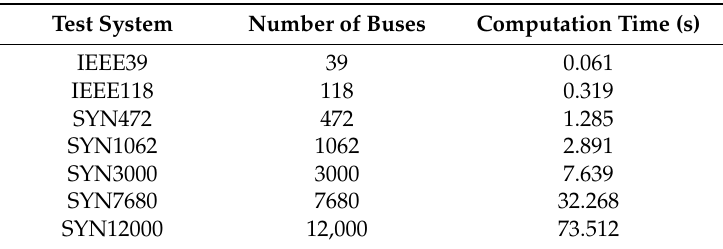
Table 6. Computation time of different test